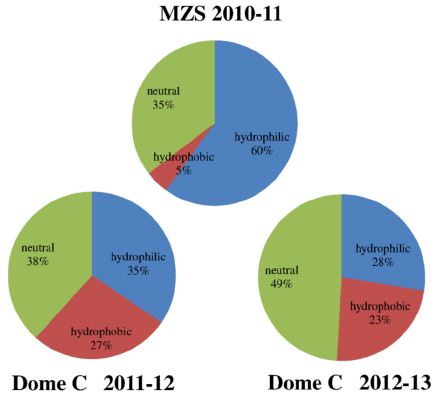
Figure 6. Comparison between percentages of hydrophilic, neutral and hydrophobic amino acid contributions of the aerosols sampled at the Mario Zucchelli Station and at Dome